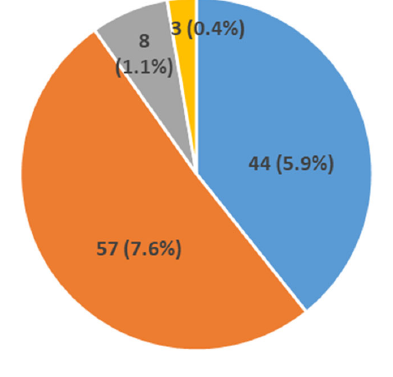
Figure 4. Distribution of point mutations in DMD (red) or BMD (blue) analyzed patients.